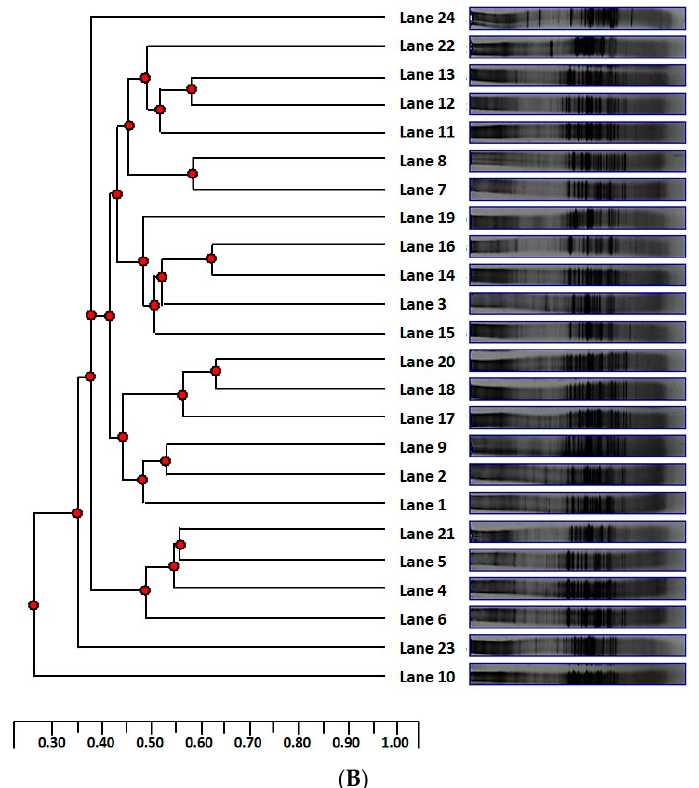
Figure 4. Denaturing gradient gel electrophoresis (DGGE) analysis ( A ) and unweighted pair groups with mathematical averages (UPGMA) dendrogram ( B ) of 16S rRNA gene fragments representing the bacterial population amplified from DNA extracted from digesta from rats six weeks after the second AOM injection (2 × 15 mg/kg). ( A ) Bands of interest are indicated by arrows and numbered 1 to 12. Bands 1 to 7 were cut out for DNA extraction and sequencing. ( B ) Scale refers to similarity index Lane 1–4: C = cellulose; Lane 5–8: P = pectin; Lane 9–12: CE = cellulose + EGCG; Lane 13–16: PE = pectin + EGCG; Lane 17–20: Cin = cincau extract; Lane 21–24: CinL = Cincau leaves. EGCG, 0.1% epigallocatechin-3-gallate. Table 3. Closest relatives of DNA sequences of bands excised after denaturing gradient gel electrophoresis (DGGE) in Figure 4. DNA was extracted, amplified and sequenced from the digesta of rats fed different diets, six weeks after the second AOM injection (2 × 15 mg/kg).